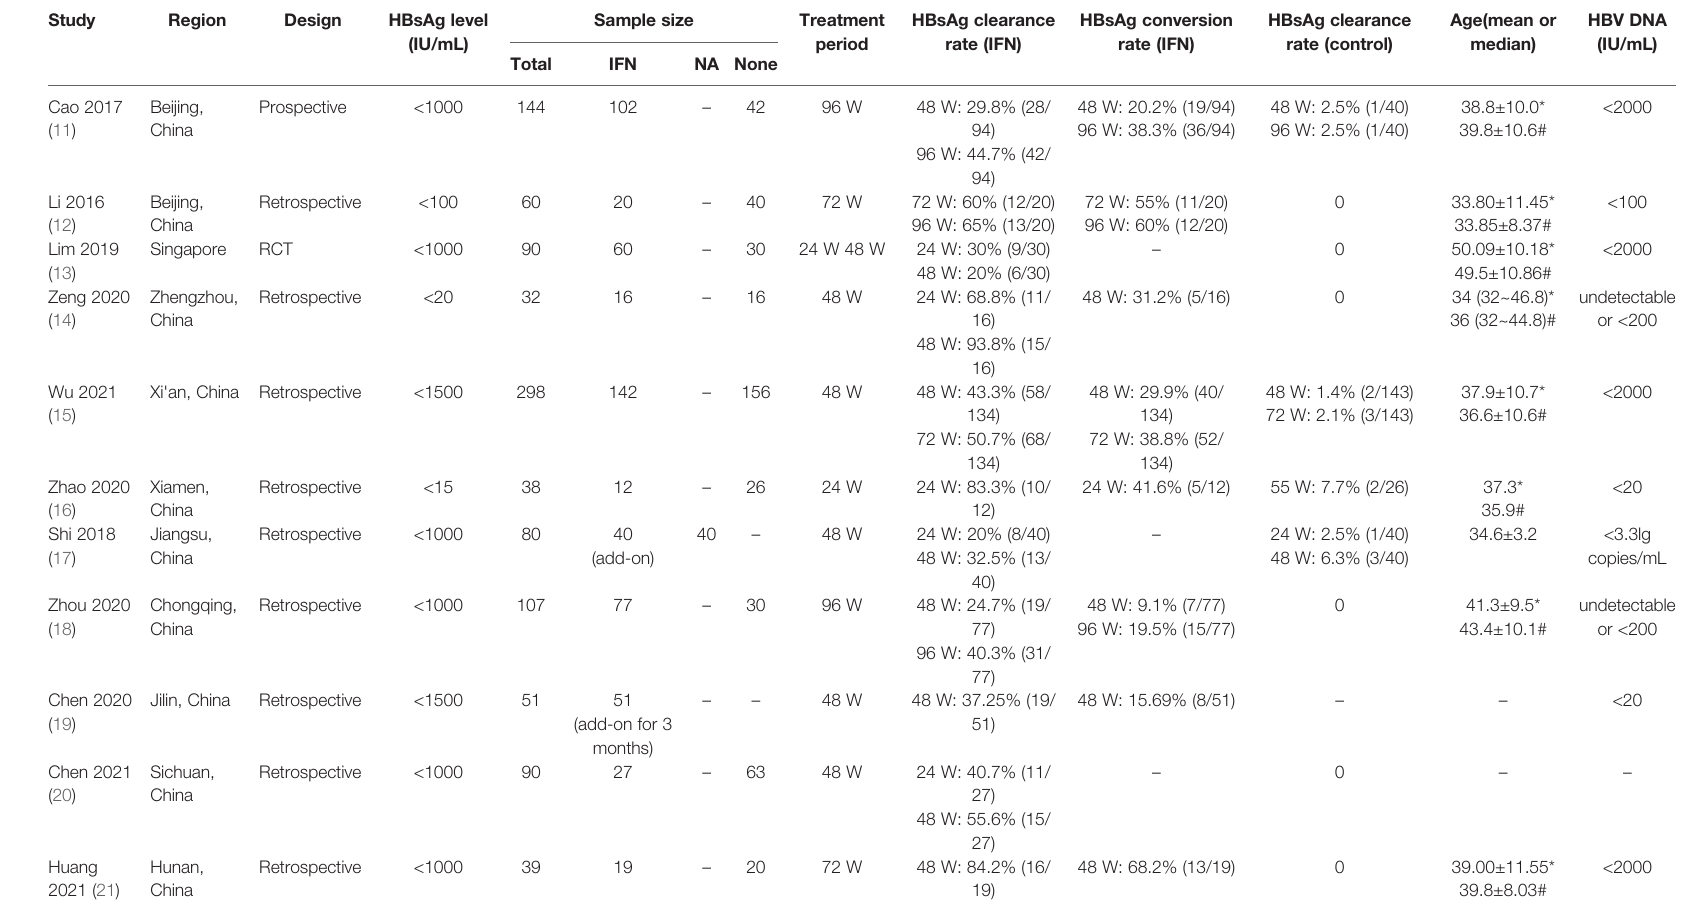
TABLE 1 | Characteristics of the included